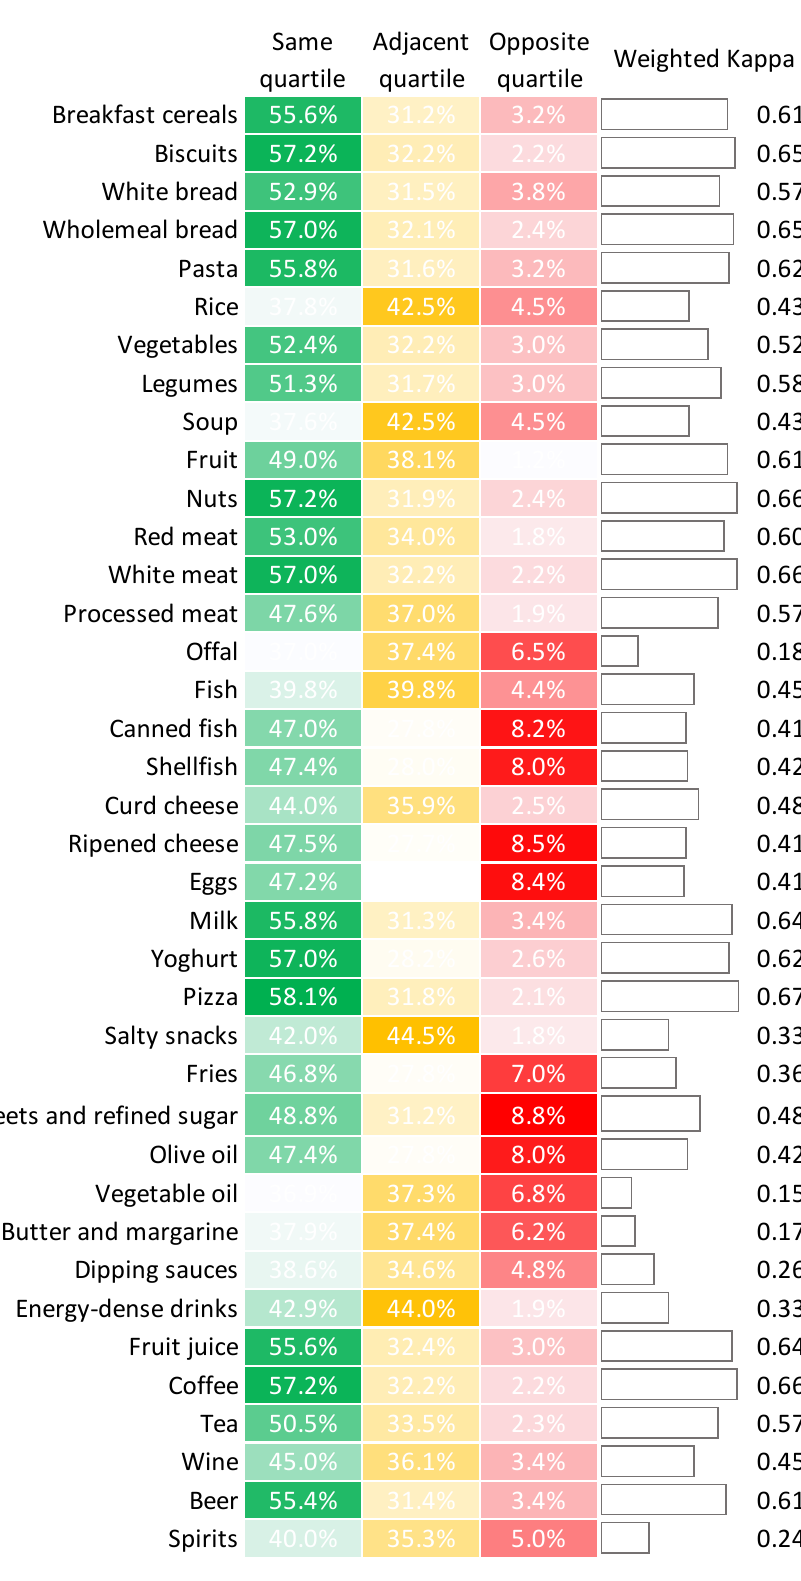
Figure 5. Cross-classification and weighted-kappa analyses of dietary data obtained from the web- app and the food frequency questionnaire. For the cross-classification analysis, more than 50% of participants should be classified into the same quartile, while those classified into the opposite quartile should not exceed 10%. For the weighted kappa analysis, the value should be above